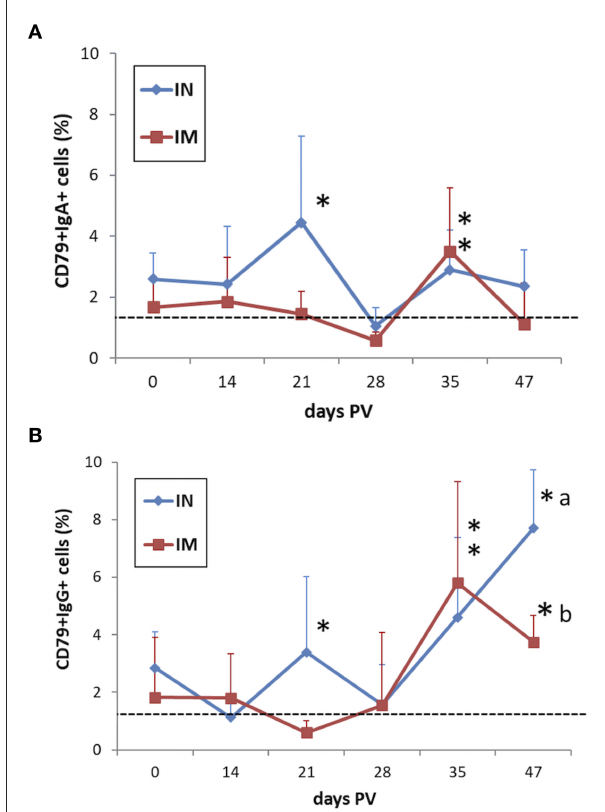
FIGURE9 Frequencies of (A) CD79 α + IgA + and (B) CD79 α + IgG + B cells in M. hyopneumoniae -stimulated PBMC of IN-vaccinated (nano-adjuvanted dry powder vaccine) and IM-vaccinated piglets. PBMC were recalled in vitro with inactivated M. hyopneumoniae at a ratio of 100 bacterins/cell ( ∼ 50 µ g/ml) for 44h. The levels are reported after subtraction of the corresponding values in unstimulated cell samples. Asterisks (*) indicate a statistically significant difference between the corresponding treatment group and the control group ( p < 0.05). The mean value of the mock-vaccinated control group at 0 days PV (dashed line) was used as reference value for group comparisons throughout the study period. Different superscript letters indicate a statistically significant difference between the two treatment groups ( p < 0.05). IN, intranasally; IM, intramuscularly; PV,